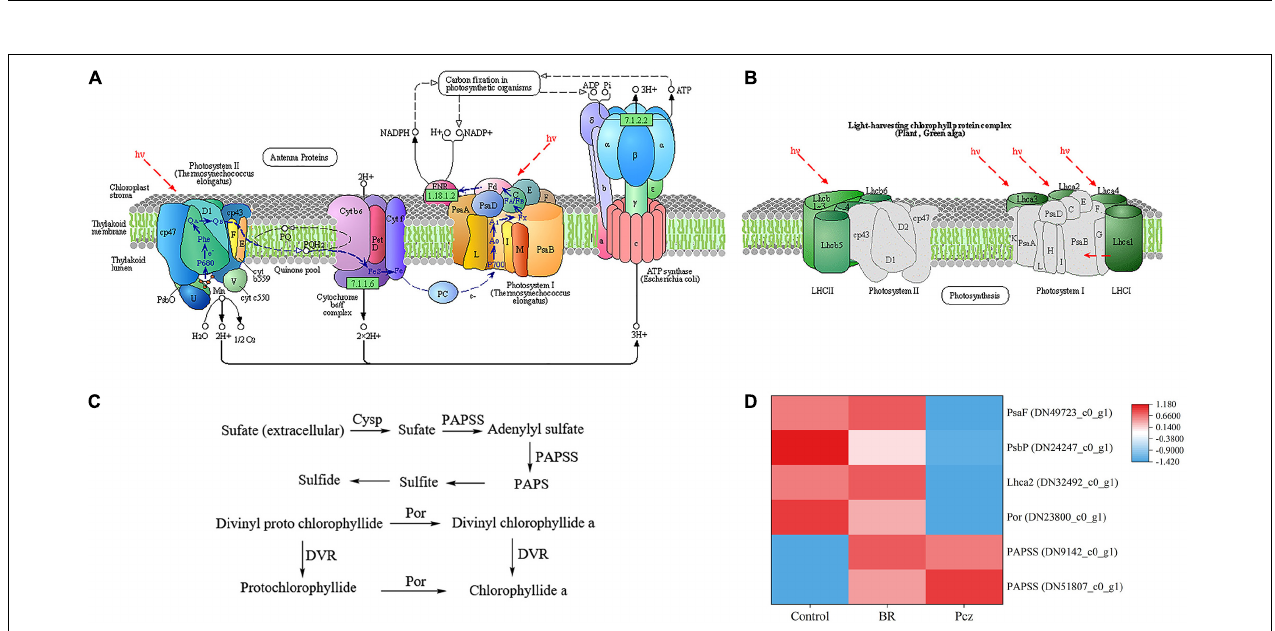
FIGURE 7 | Analysis of differentially expressed levels related to photosynthesis pathway of P. ternata under BR and Pcz treatments. (A) The photosynthesis pathway. (B) The photosynthesis of antenna proteins. (C) Sulfur assimilation and chlorophyll a synthesis pathway. (D) The expression levels of genes related to the photosynthesis pathway. Blue indicates a lower expression level, whereas red indicates a higher expression level. All data showed the average mean of three biological replicates.